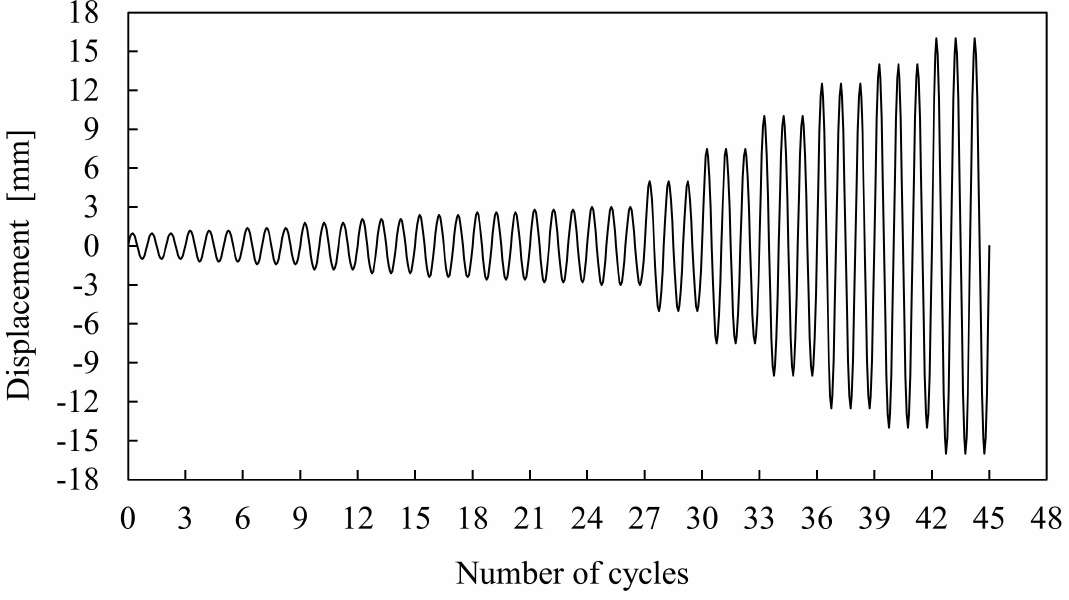
Figure 23. Applied loading scheme on the PCSP-ISF test